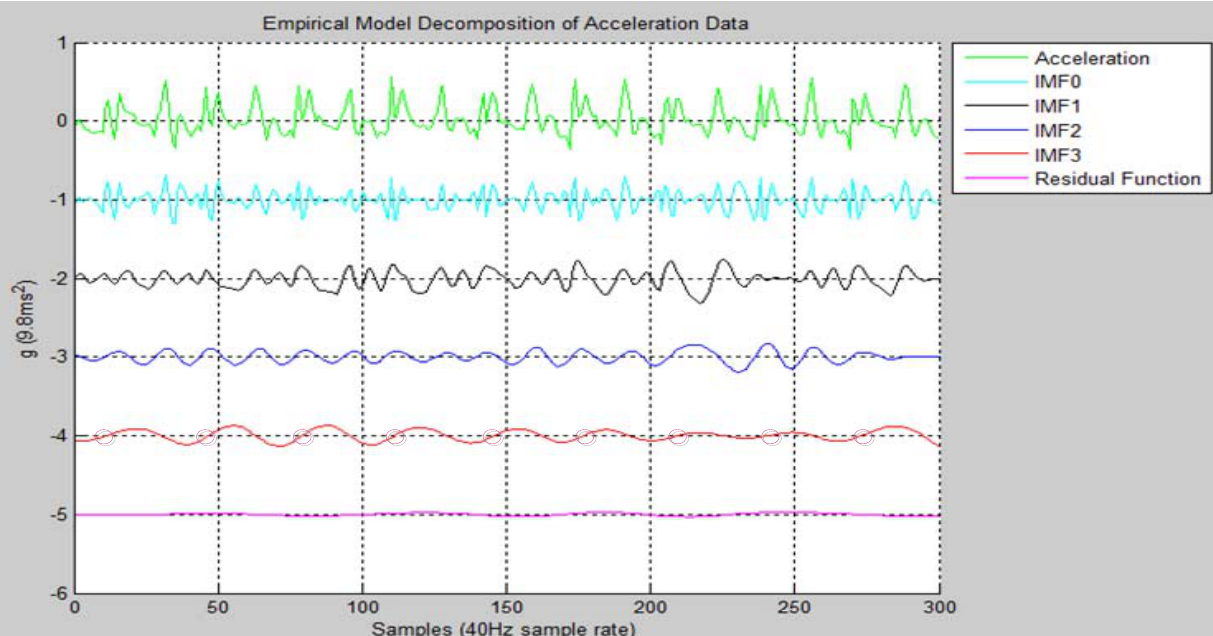
Figure 9. EMD results of acceleration data for walking 9